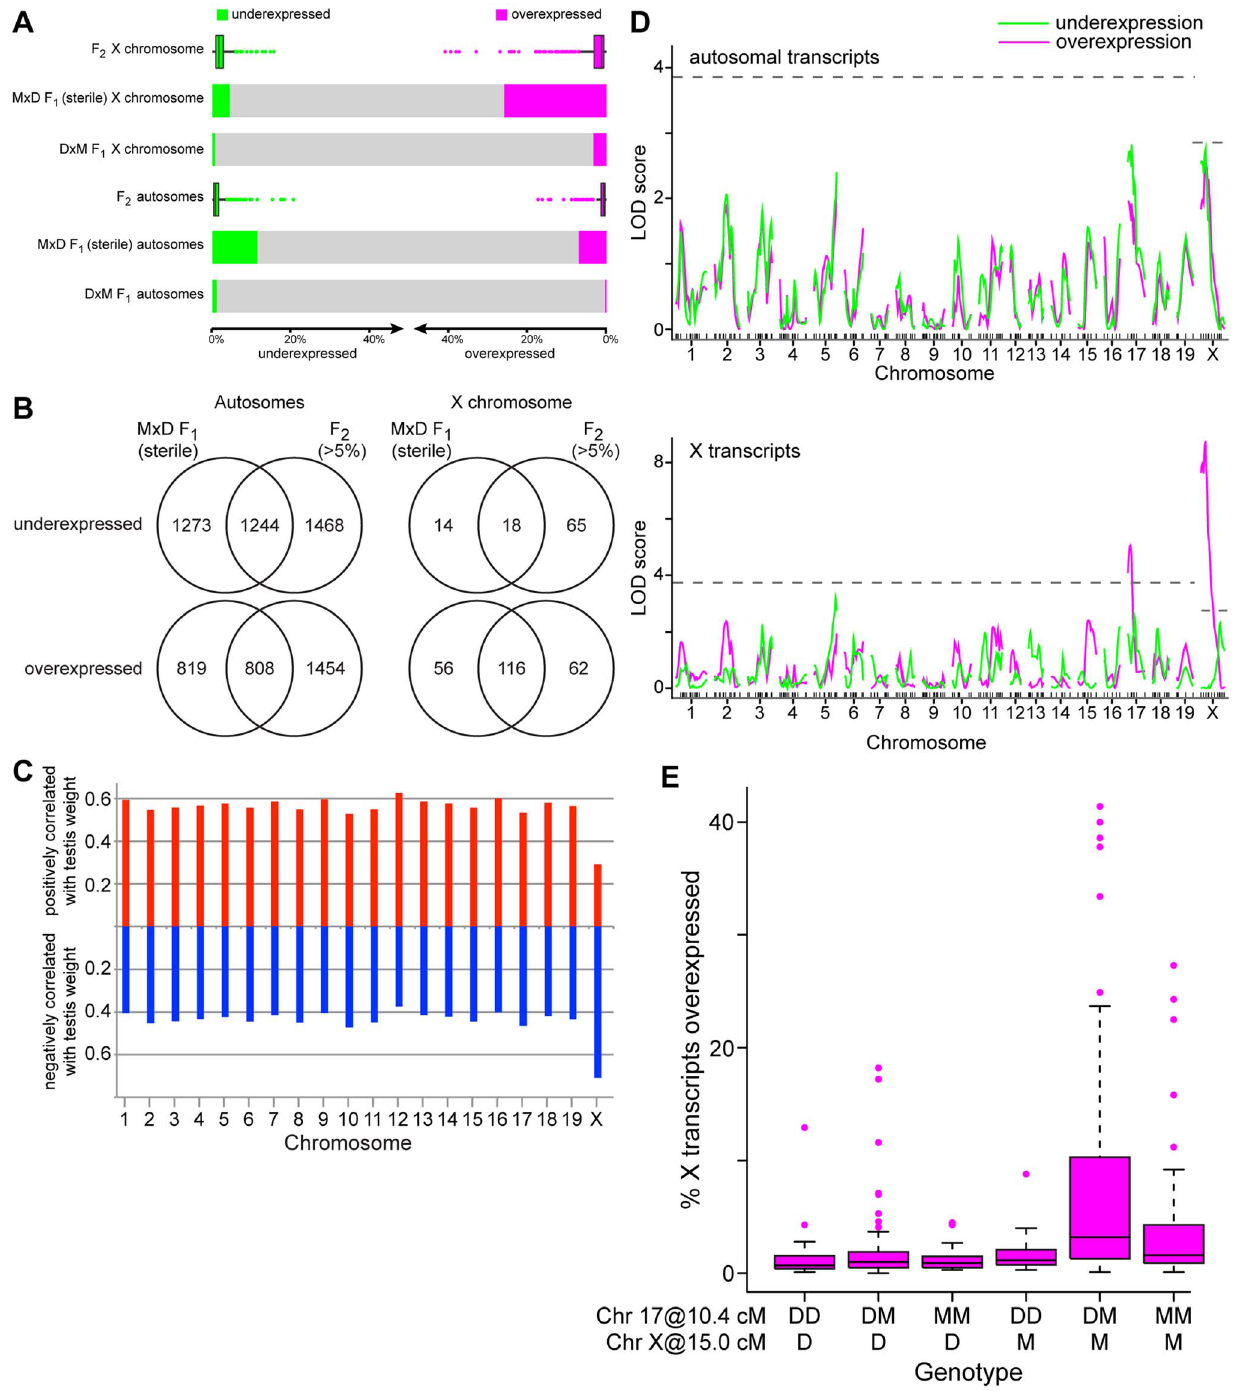
Figure 1. Misexpression in testes of F 1 and F 2 hybrids. (A) Proportions of underexpressed (green) and overexpressed (magenta) transcripts in fertile (DxM) F 1 s, sterile (MxD) F 1 s, and F 2 s. Mean values are shown for F 1 s and boxplots for F 2 s indicate median, interquartile range, and outliers . 1.5 6 interquartile range are shown as points. (B) Proportions of misexpressed transcripts common to sterile (MxD) F 1 s and F 2 s. (C) Columns indicate proportions of transcripts on each chromosome significantly positively (red, upward) and negatively (blue, downward) correlated with right relative testis weight. (D) QTL mapping of misexpression (number of under- or over-expressed transcripts/individual) in F 2 s. Significance thresholds, determined by permutation, are indicated with dashed lines. (E) Overexpression of X-linked transcripts in F 2 s by two-locus genotype for chromosomes 17 (10.4 cM) and X (15.0 cM). Boxes indicate interquartile range, horizontal lines indicate medians, and whiskers extend to 1.5 6 interquartile range. Outliers are indicated with points.